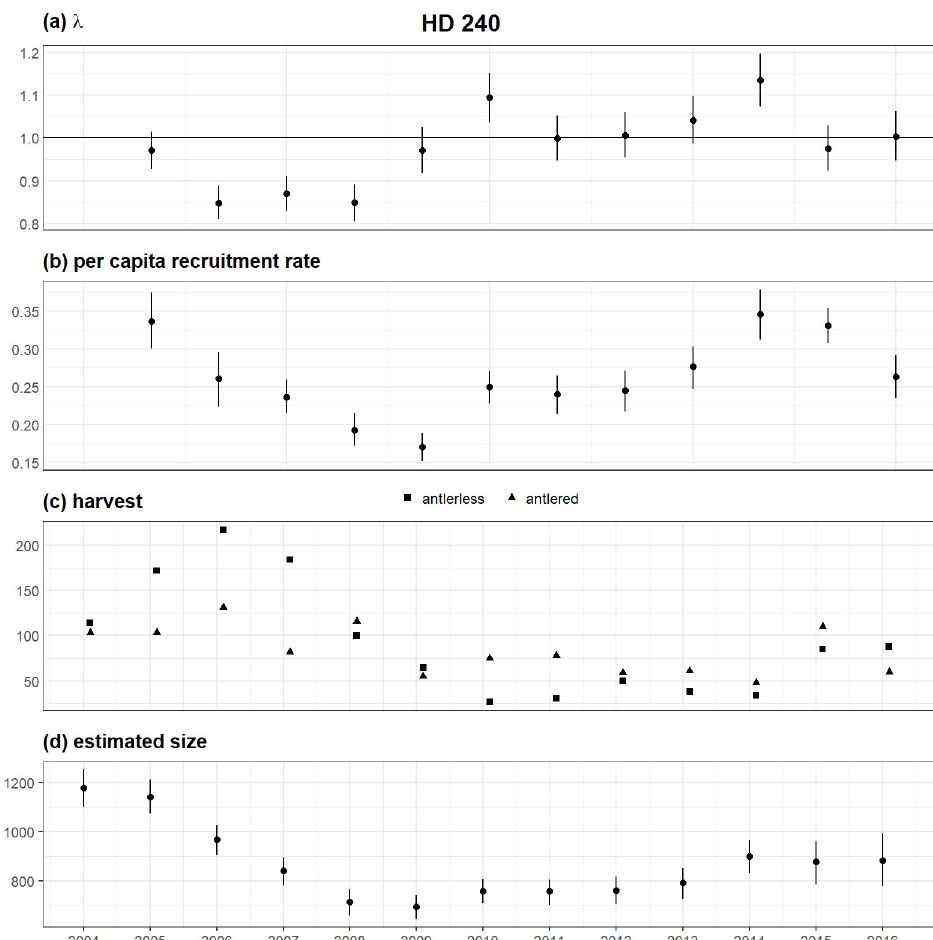
Fig 7. Demographic summary of an example hunting district (HD 240), including population growth rate, per capita recruitment rate, observed harvest, and predicted/observed size. The black dot denotes the median of the approximate posterior distribution, the heavy black line the 50% highest posterior density interval (HPD) and the light black line the 90% HPD interval.